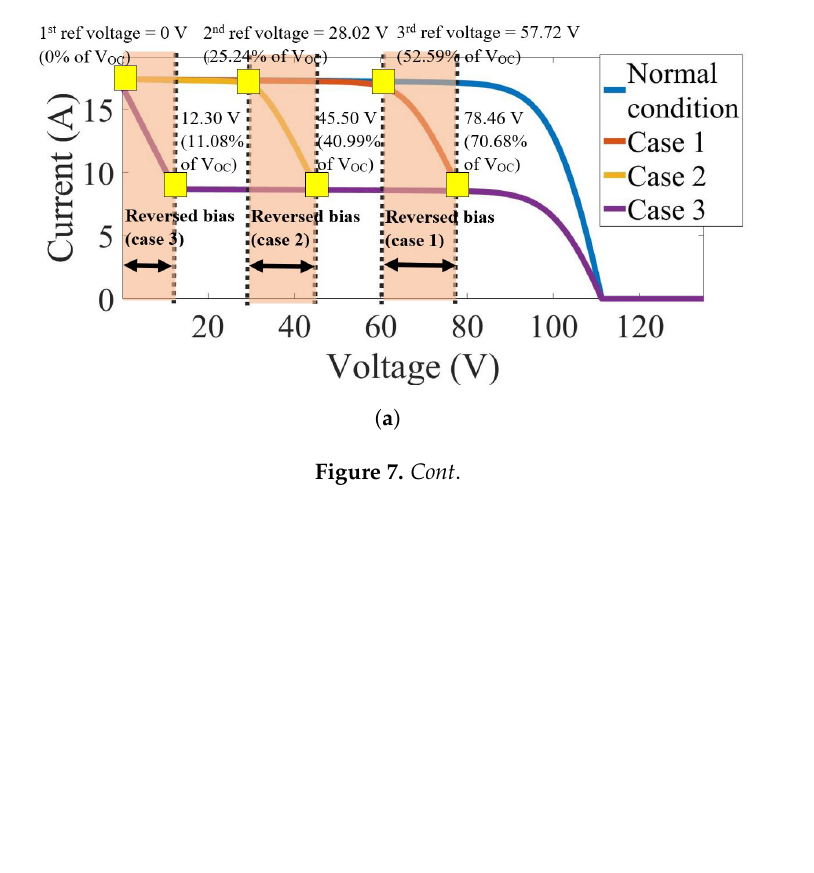
Figure 6. Diagram for the hotspot PV array: ( a ) case 1; ( b ) case 2; ( c ) case 3; ( d ) case 4; ( e ) case 5; ( f ) case 6.